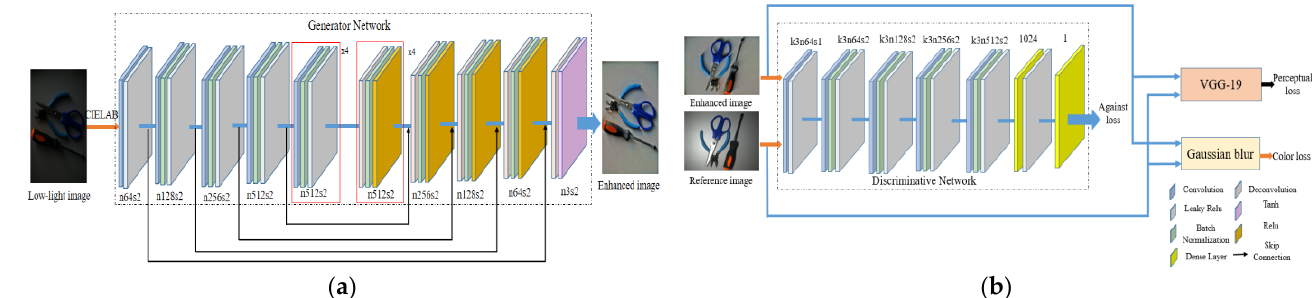
Figure 4. Adversarial generation network model for low-light images: ( a ) generator network; ( b ) discriminative network.